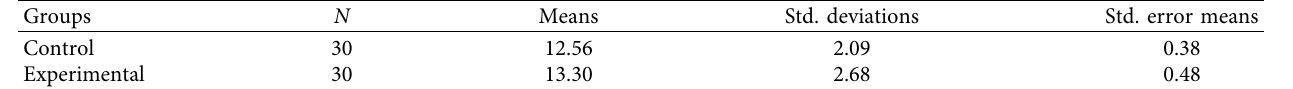
Table 6: Descriptive statistics of the experimental and control groups in the vocabulary preest.